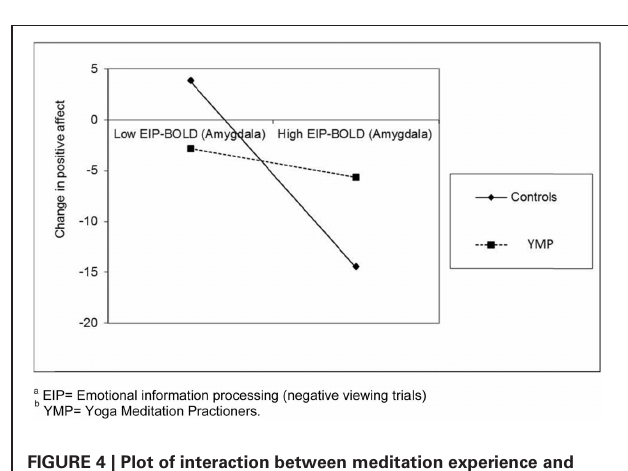
FIGURE 4 | Plot of interaction between meditation experience and BOLD response in the amygdala to viewing negative emotional images on change in positive affect during participation in the Affective Stroop task ab